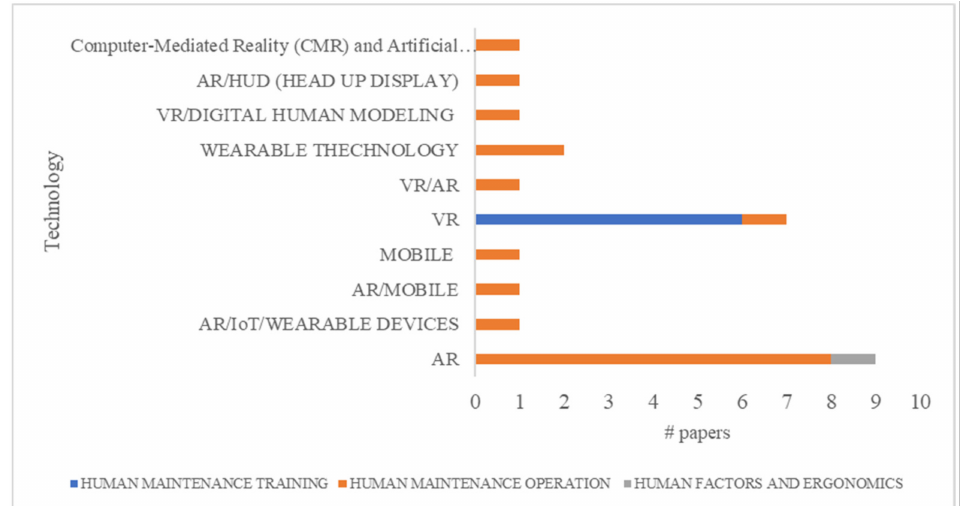
Figure 7. Numbers of papers grouped for technologies and its scope in supporting maintenance operators.